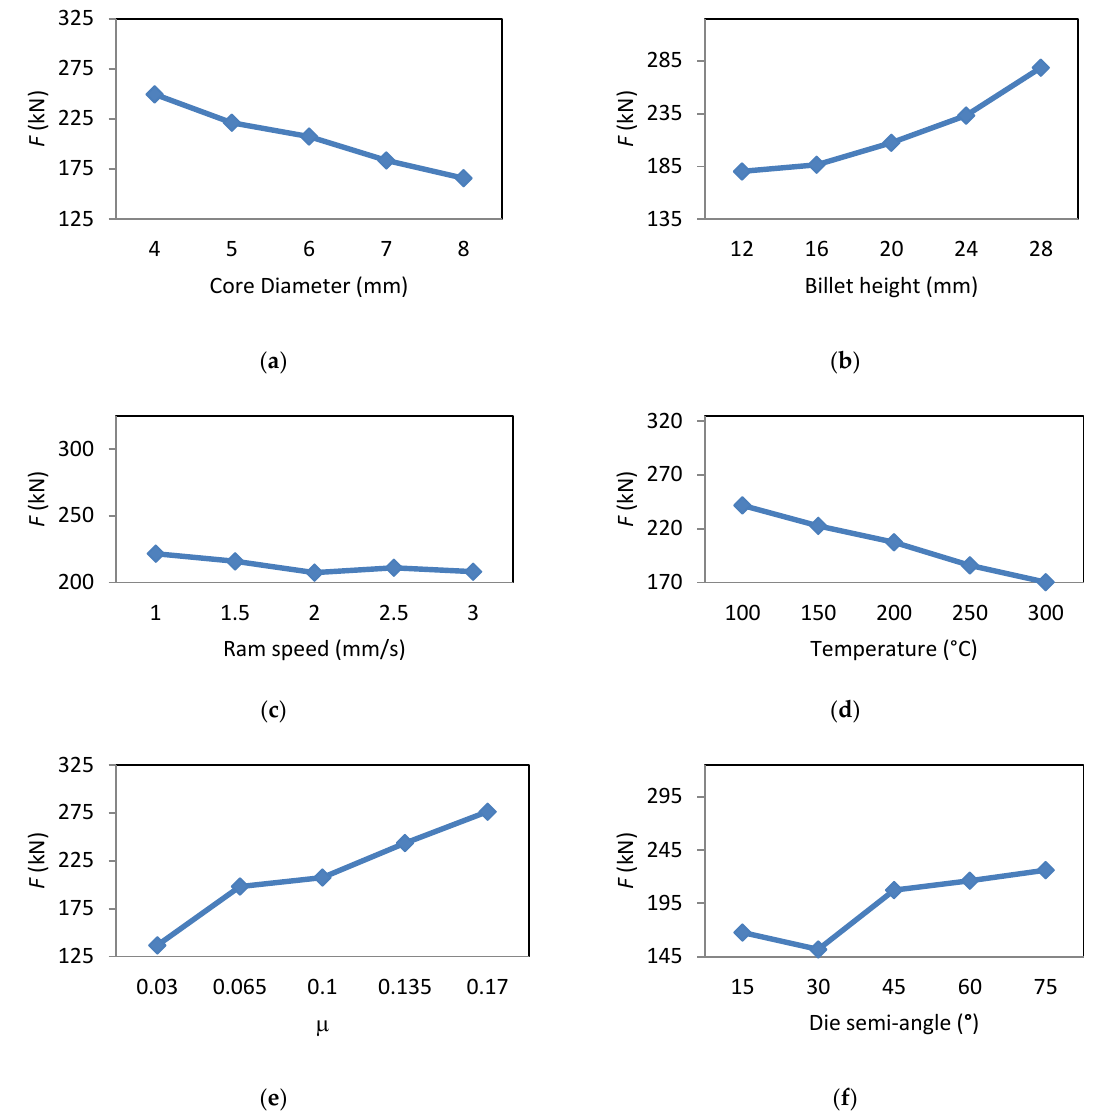
Figure 10. Influence of the parameters on the extrusion force. ( a ) *Core diameter; ( b ) *Billet height; ( c ) *Ram speed; ( d ) Temperature; ( e ) *Friction; ( f ) *Die semi-angle. *Temperature of the process is 200 °C.